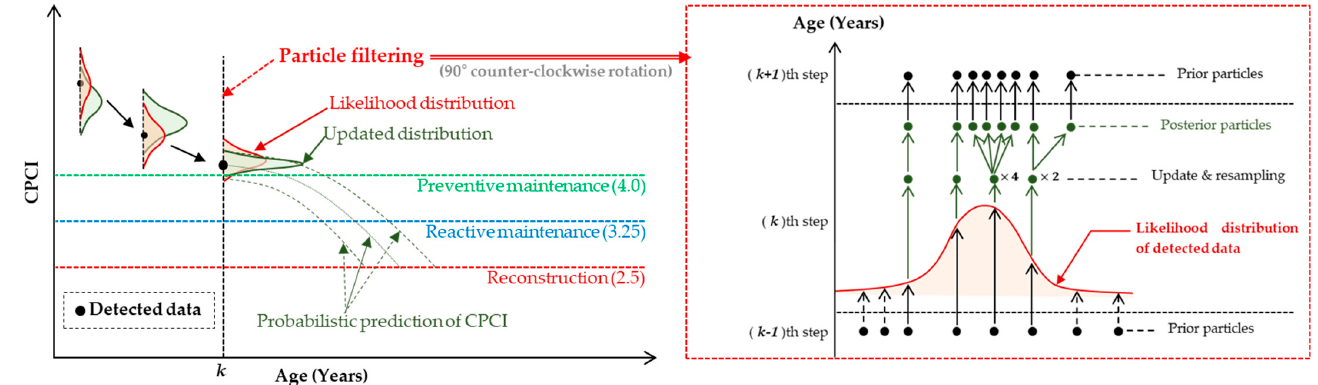
Figure 1. Intuitive schematic diagram of the particle filtering (for example).